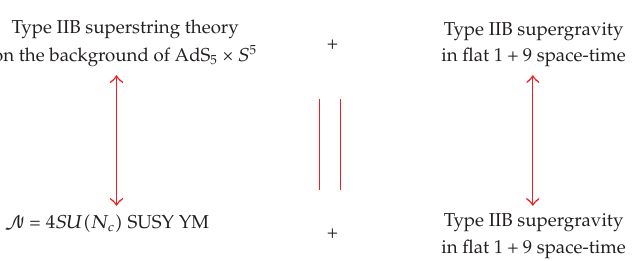
Figure 1: A diagrammatic statement of the Ads/Cft